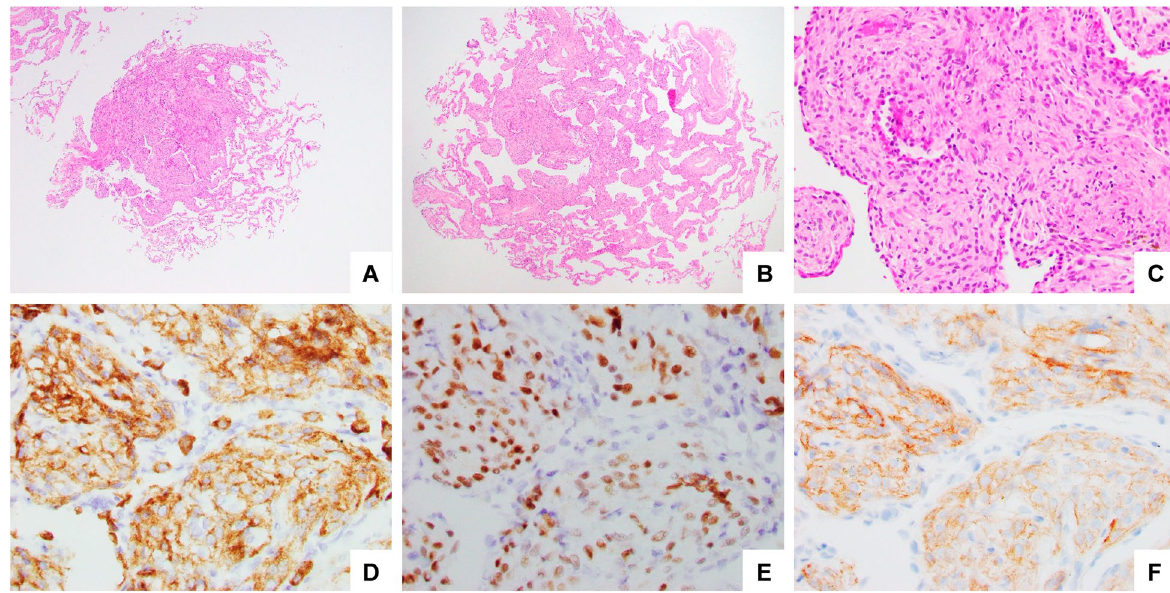
Fig. 2 Histological and immunohistological findings. A-B H&E sections showed meningothelial-like nodules which are distinct from the neighboring normal lung architecture. C Higher magnification shows an interstitial proliferation of epithelioid and spindled cells with a vague whirling and streaming pattern. D The cells comprising the nodules showed diffuse cytoplasmic staining with EMA ( E ), strong nuclear PR expression ( E ) and diffuse membranous expression with pan-TRK ( F ). Original magnification: x100 (A-B), x200 ( C-F